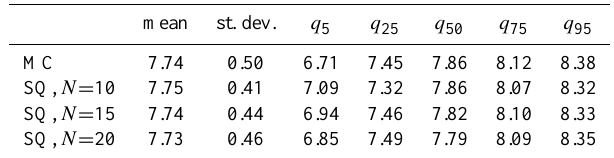
Table 1. Comparison between the estimates of some parameters of the output distribution given by the SQ with N = 10 , 15 , 20 points and by a MC with 10 3 simulations. The considered parameters are the mean, the standard deviation and the 5%, 25%, 50%, 75%, 95% quantiles.